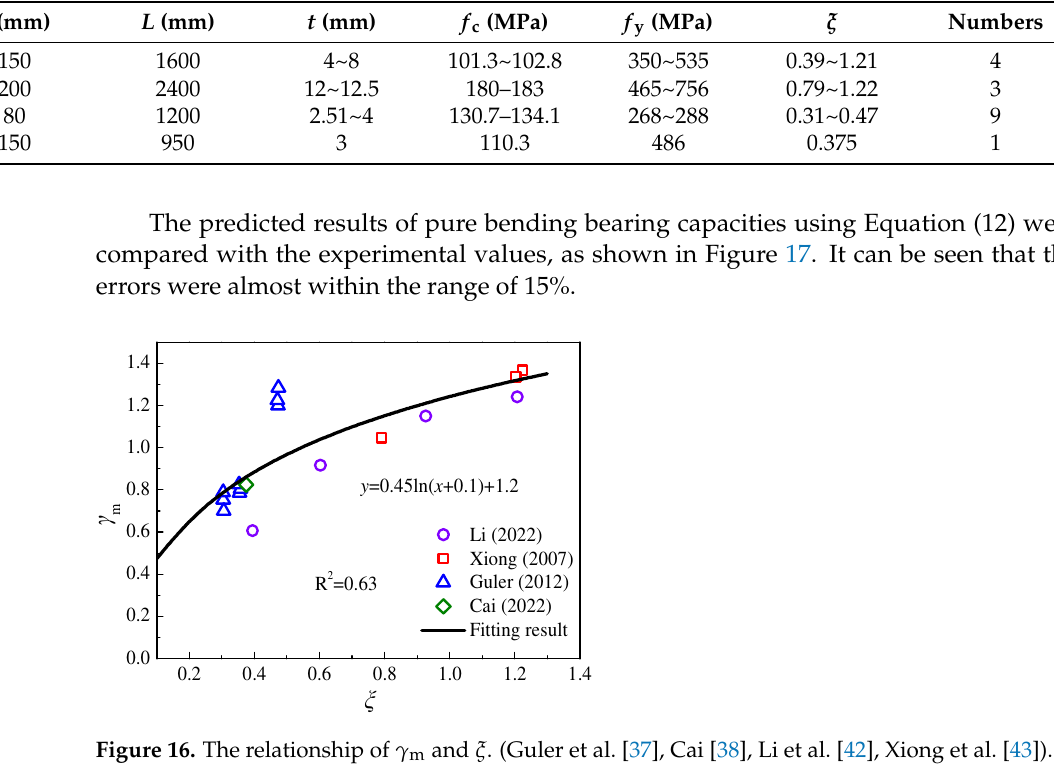
Table 5. The database of rectangular UHPCFST members subjected to pure bending.